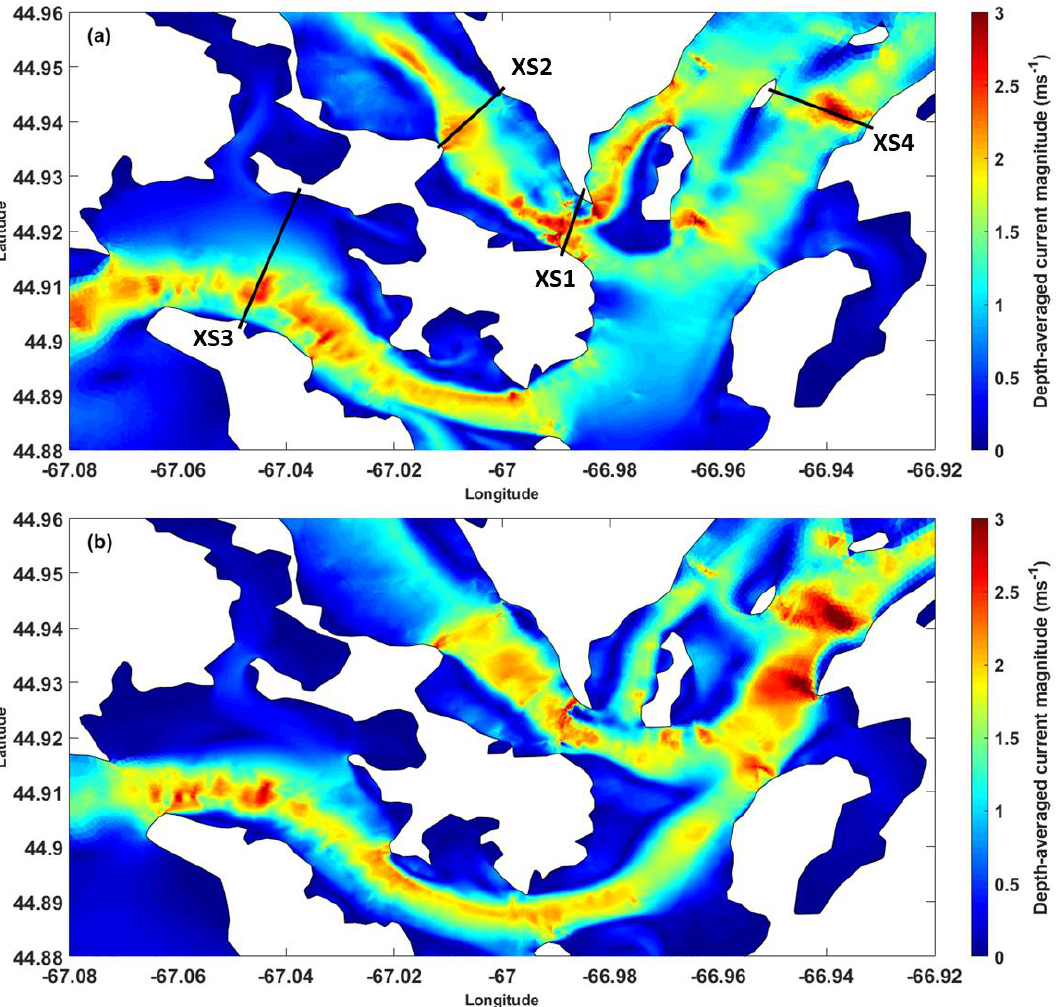
Figure 8. Depth-averaged velocity magnitudes in the Western Passage, Cobscook Bay, and Head Harbor Passage during ( a ) peak flood and ( b ) peak ebb tides in spring tide on April 28, 2017.